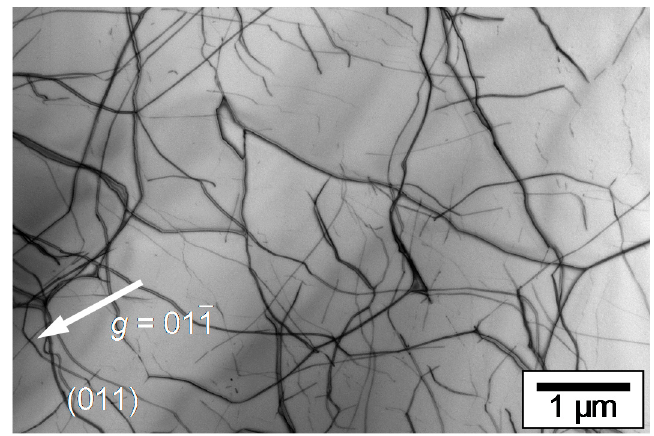
Figure 6. A typical TEM bright field image taken from the Sr / Ti = 1.00 specimen deformed at ε = 1.0 × 10 − 5 (s − 1 ) up to ε p = 3%.